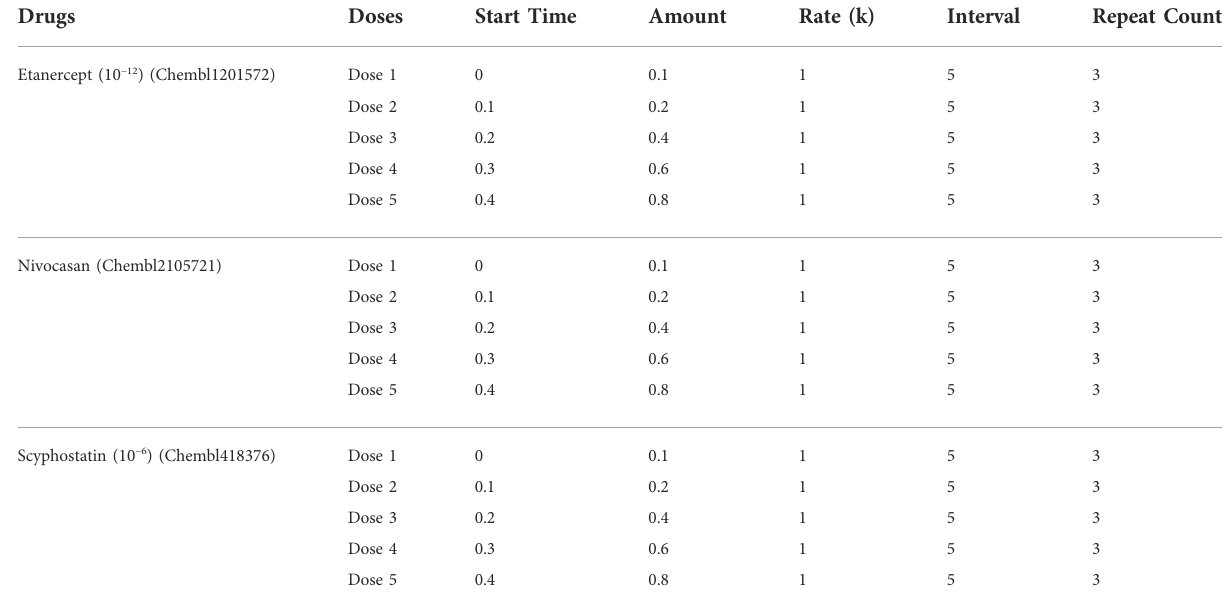
TABLE 4 Application of Drugs using Repeat